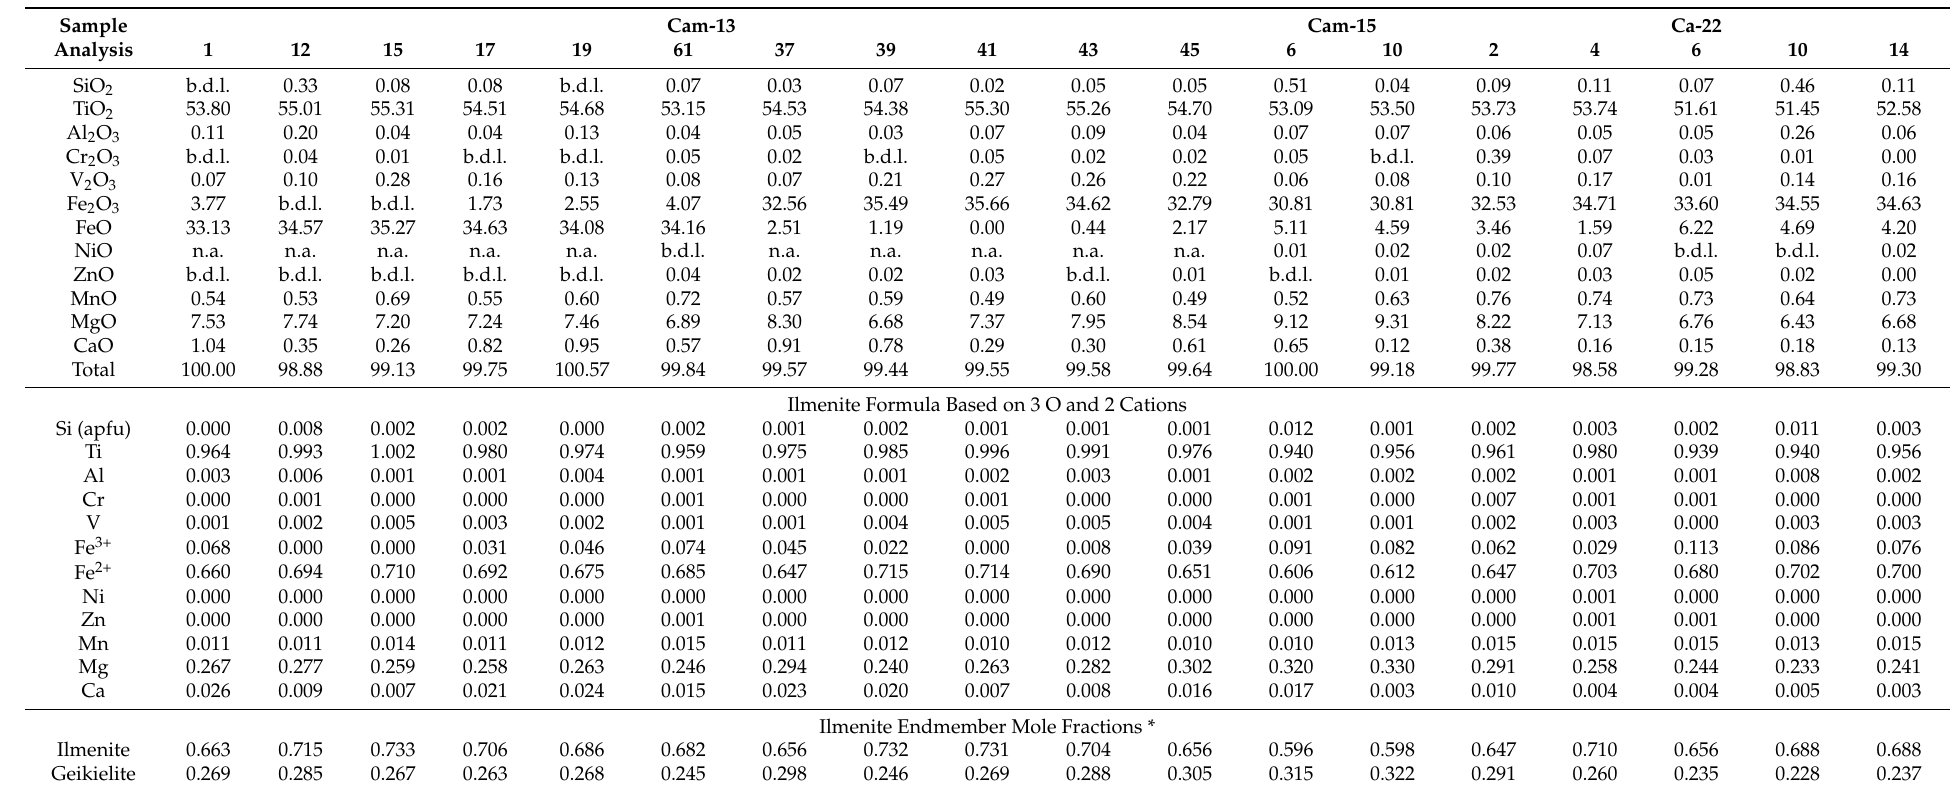
Table 4. EPMA analyses (wt% oxides) of ilmenites coexisting with